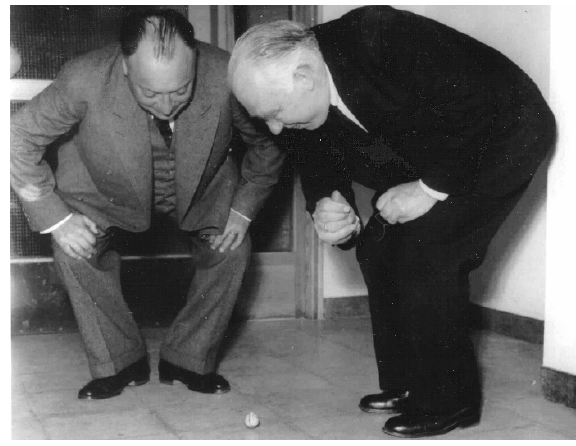
Figure 1. Wolfgang Pauli and Niels Bohr are watching a spinning top as a model for the spinning electron. Photograph by Erik Gustafson, courtesy of AIP Emilio Segré Visual Archives. Courtesy of the Margrethe Bohr collection, Kopenhagen.